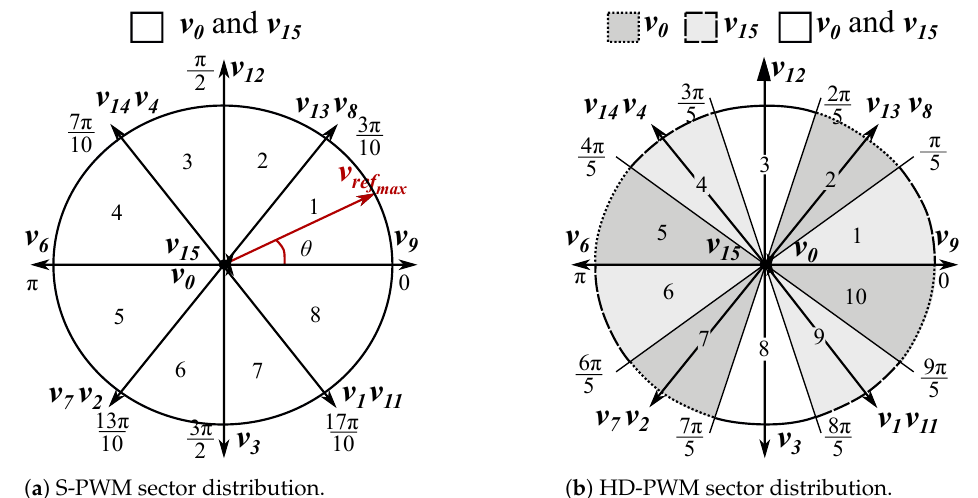
Figure 2. Sector distribution of continuous and discontinuous PWM schemes.